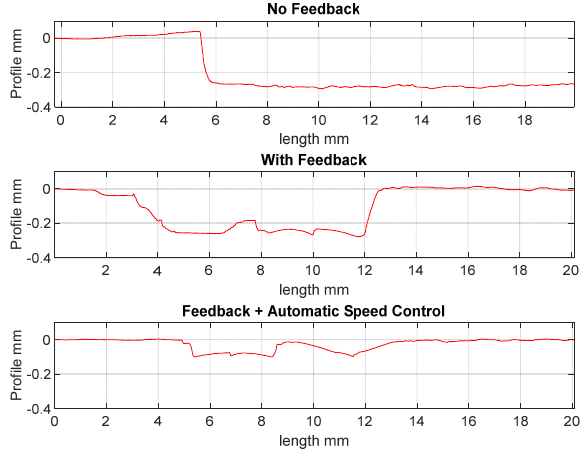
Figure 34. Surface profile measurement comparison.